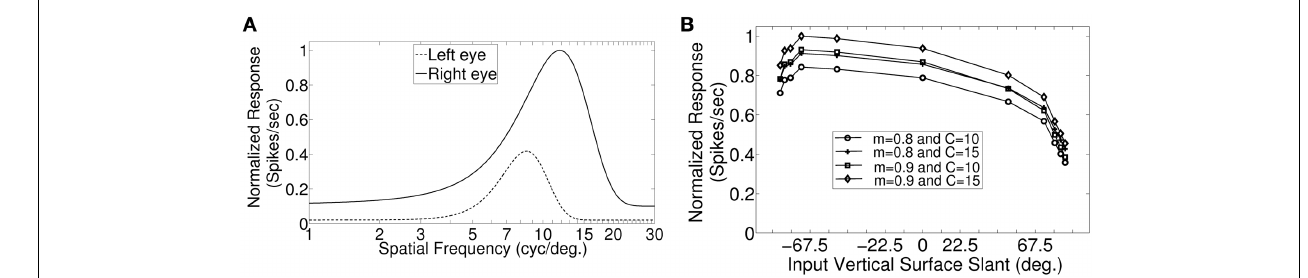
FIGURE 7 | Monocular SF tuning characteristics of a hypothetical monkey cell H and its vertical surface slant tuning. (A) The left and the right eye SF tuning characteristics of a hypothetical monkey cell H. (B) Vertical slant tuning for cell H.